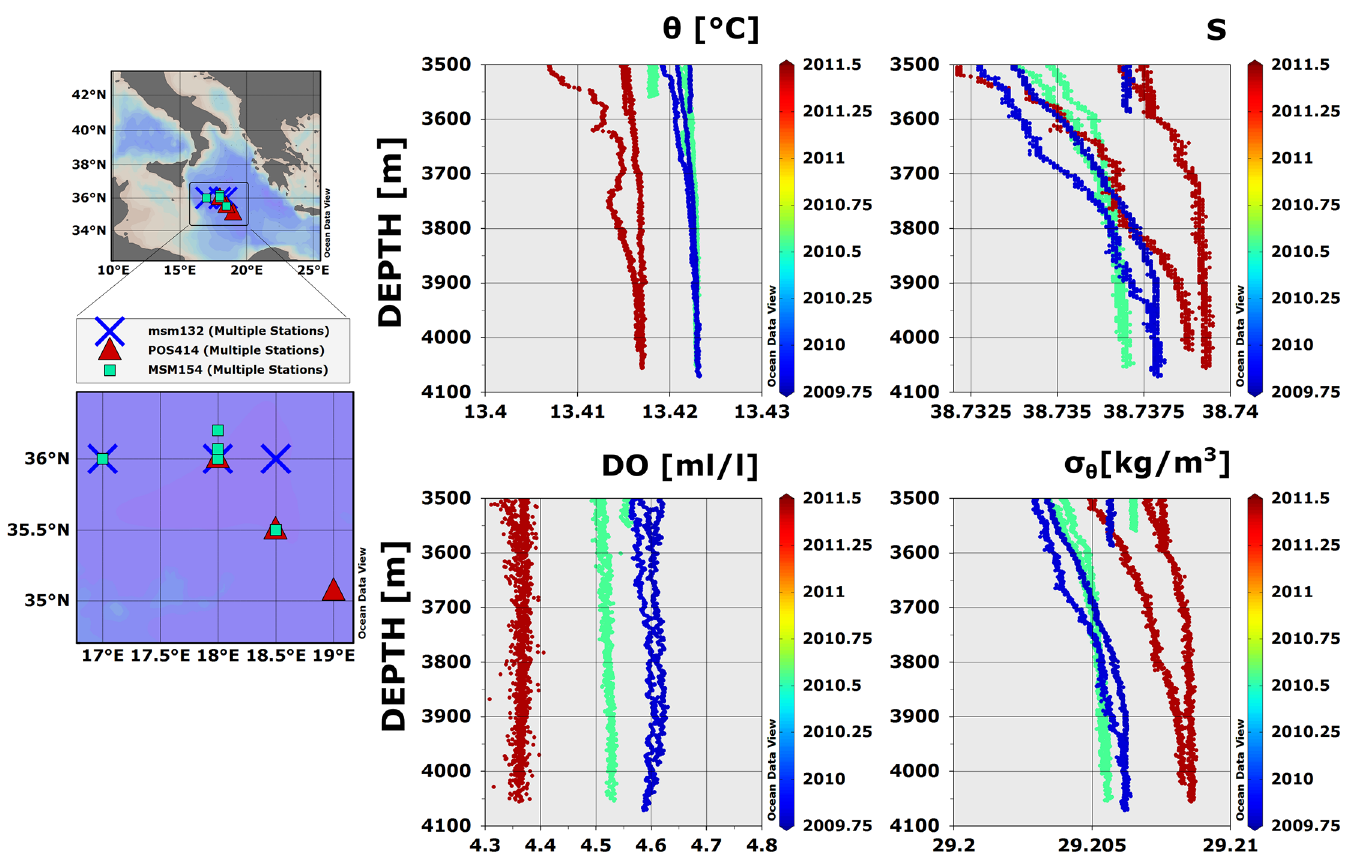
Fig 2. Vertical distribution of geophysical quantities in the abyssal Ionian Sea. Potential Temperature ( θ ,) Salinity (S), Dissolved Oxygen (DO), and Potential Density Anomaly ( σ θ ) were measured in the abyssal plain of the Ionian Sea in October 2009, July 2010 and June 2011. The data refers to depths > 3500 m. Colours individuate the different cruises (red: POS414; blue MSM 13 – 2; green: MSM 15 – 4). The vertical profiles refer to the locations mapped in the left panels (colour code is the same as for the right panels).